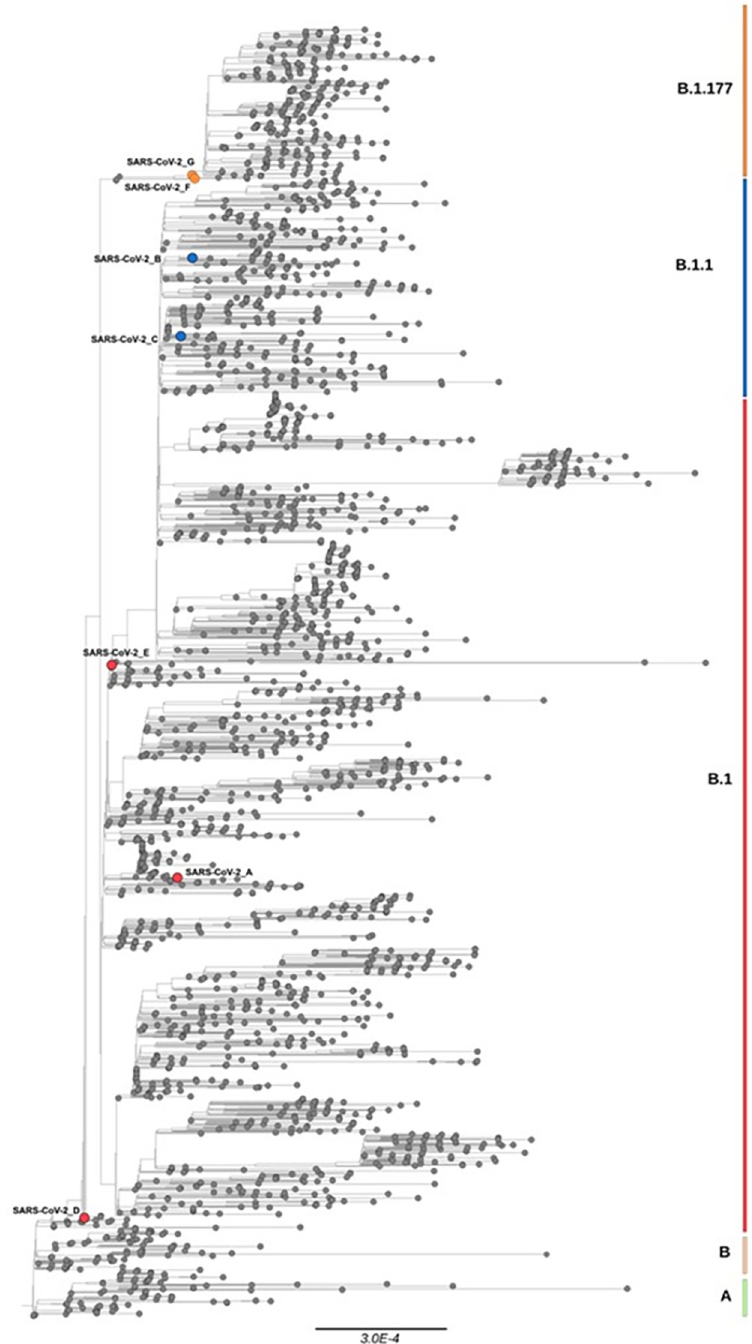
Fig 2. Maximum-likelihood (ML) tree of SARS-CoV-2 sequences. The ML tree includes 2463 SARS-CoV-2 sequences retrieved globally from GISAID database until December 2021 and 7 SARS-CoV-2 sequences evaluated in this study represented as dots. SARS-CoV-2 sequences of this study are colored by lineages: B.1 in red; B.1.1 in blue; B.1.177 in orange; all the other world sequences in black.